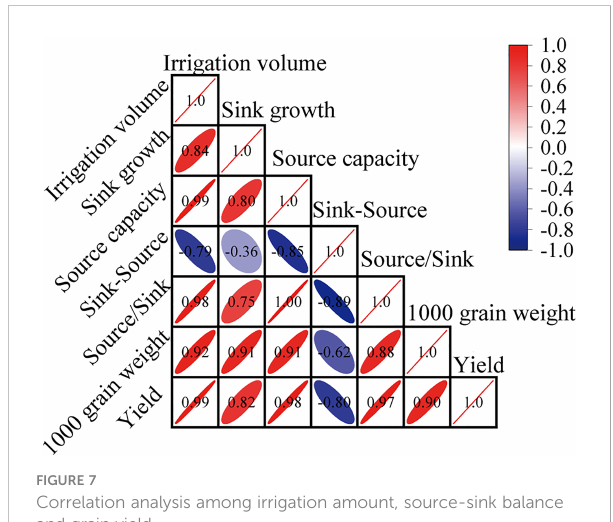
FIGURE 7 Correlation analysis among irrigation amount, source-sink balance and grain